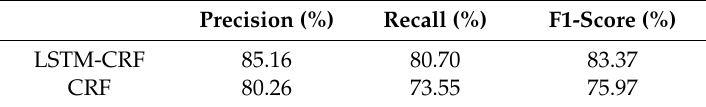
Table 4. Average performance metrics for all entity types.